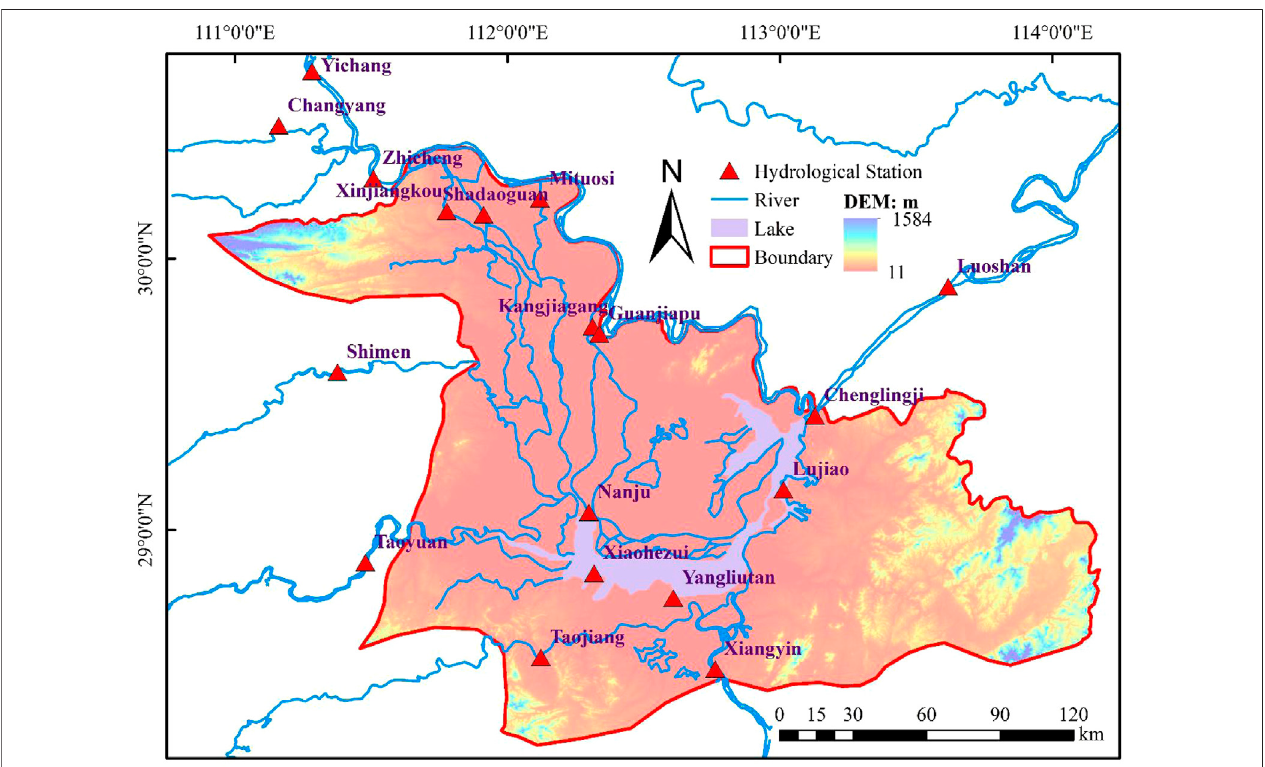
FIGURE 1 | River networks and hydrological stations in the Dongting Lake area.